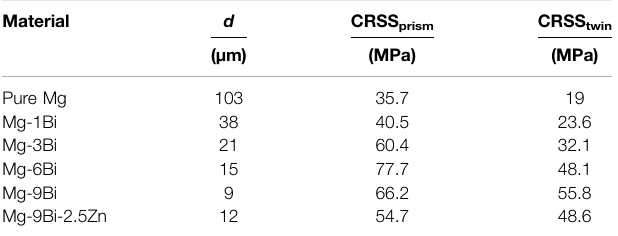
Frontiers in Materials |